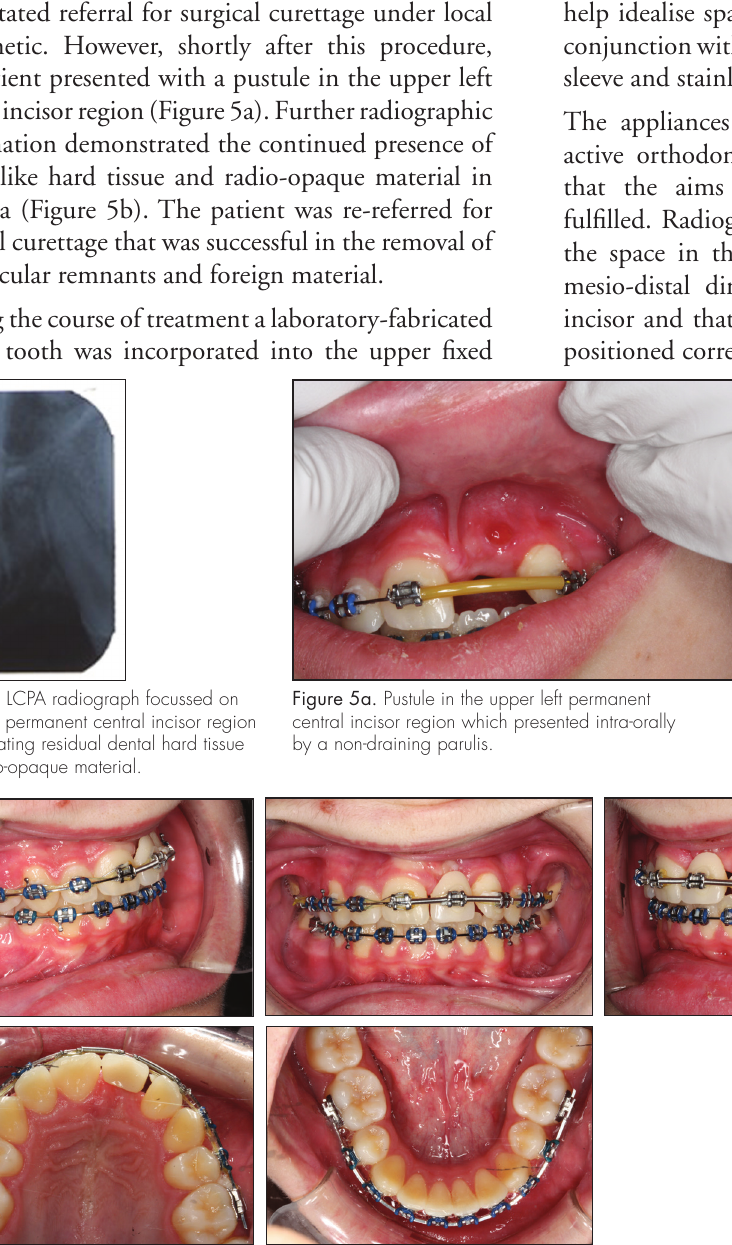
Figure 6. Mid-treatment intra-oral photographs. Note the laboratory-fabricated acrylic tooth in situ.